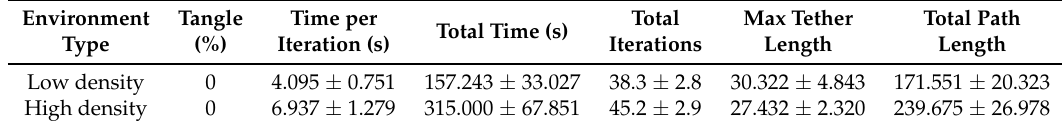
Table 4. Results using true distance to frontiers at ∆ L = 2 π R .